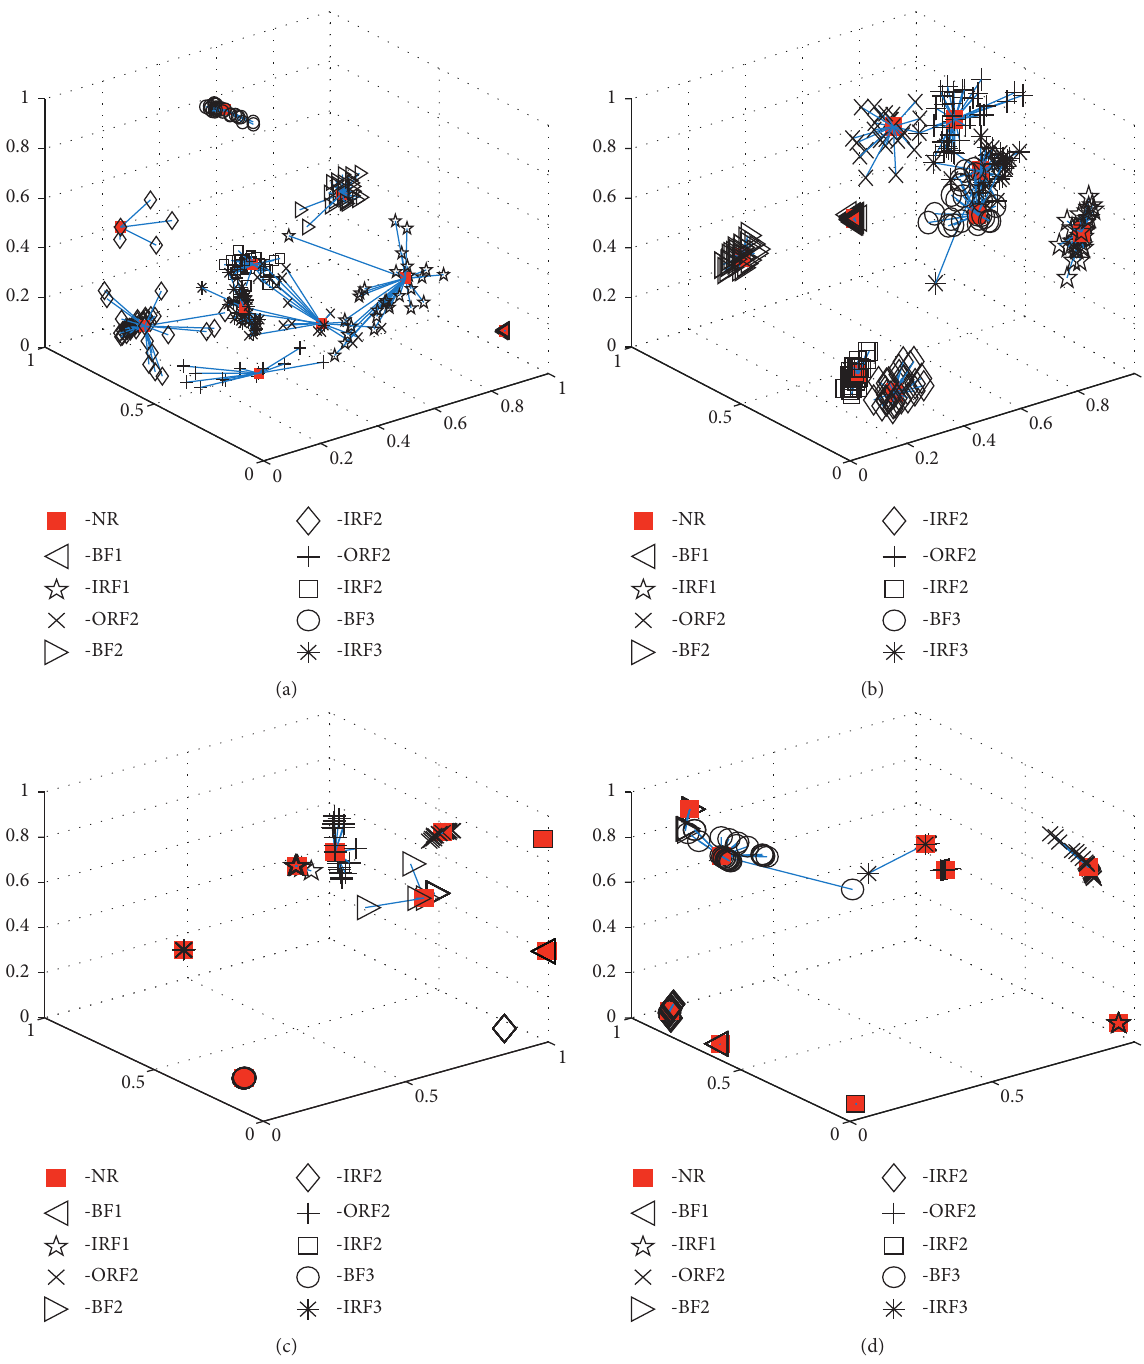
Figure 9: The 3-dimensional clustering results for the training dataset by using an SAE/SDAE with adAP. (a) SAE-A-training data-adaptive AP. (b) SAE-B-training data-adaptive AP. (c) SDAE-A-training data-adaptive AP. (d) SDAE-B-training data-adaptive